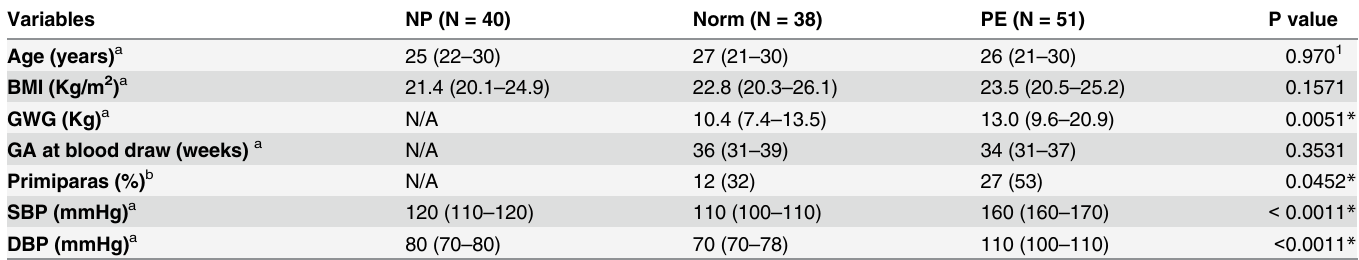
Table 1. Clinical characteristics of the studied participants.